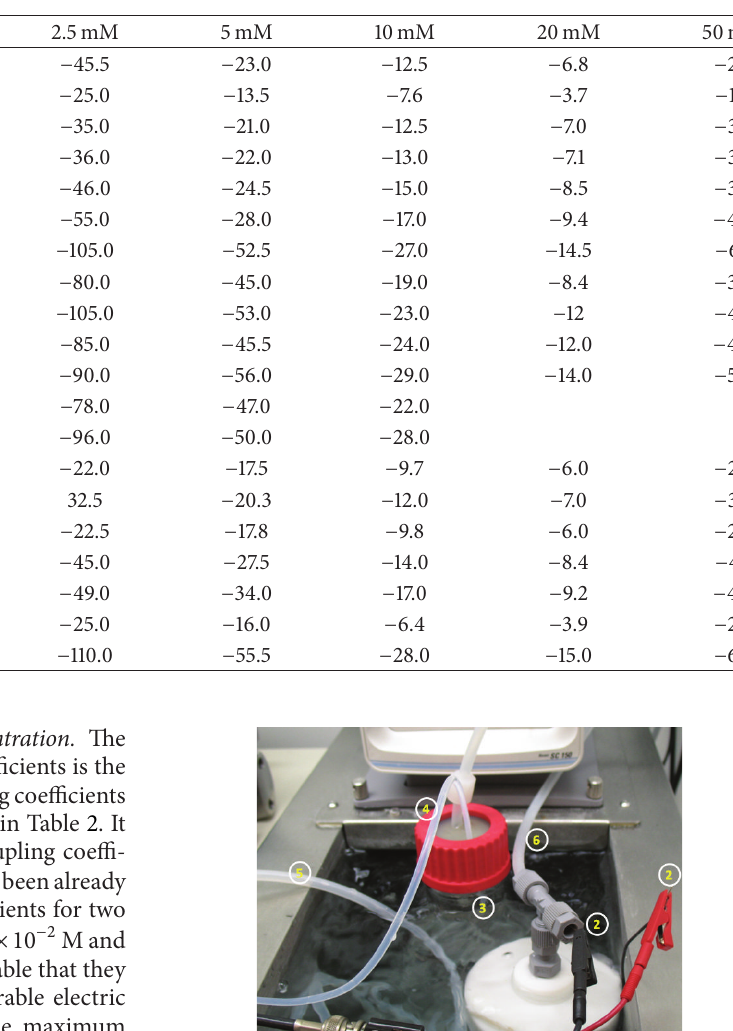
Table 2: The coupling coefficients (in mV/bar) for different concentrations of 4.0 × 10 −4 M, 10 −3 M, 2.5 × 10 −3 M, 5.0 × 10 −3 M, 10 −2 M, 2.0 × 10 −2 M, and 5.0 × 10 −2 M, respectively.